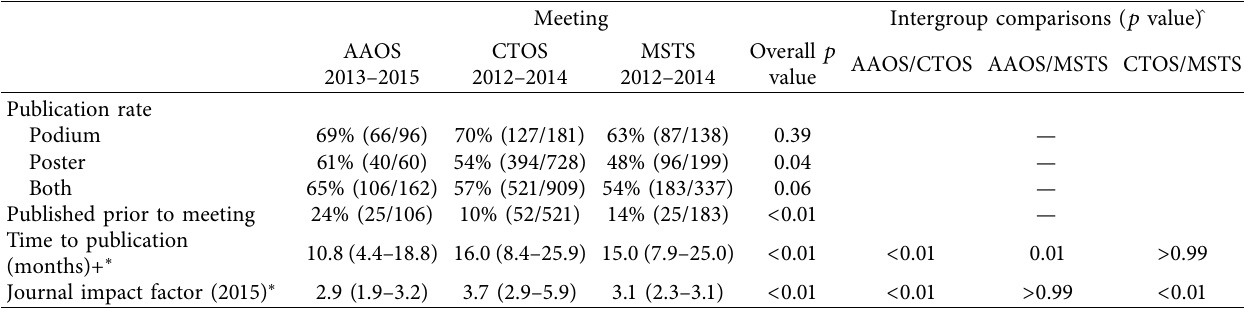
Table 1: Publication rates and characteristics of oncology abstracts presented at AAOS, CTOS, and MSTS meetings.